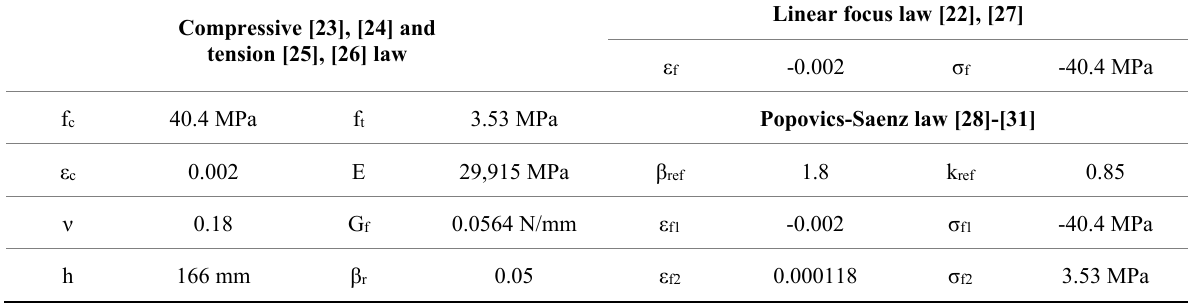
Table 1. Material parameters: direct